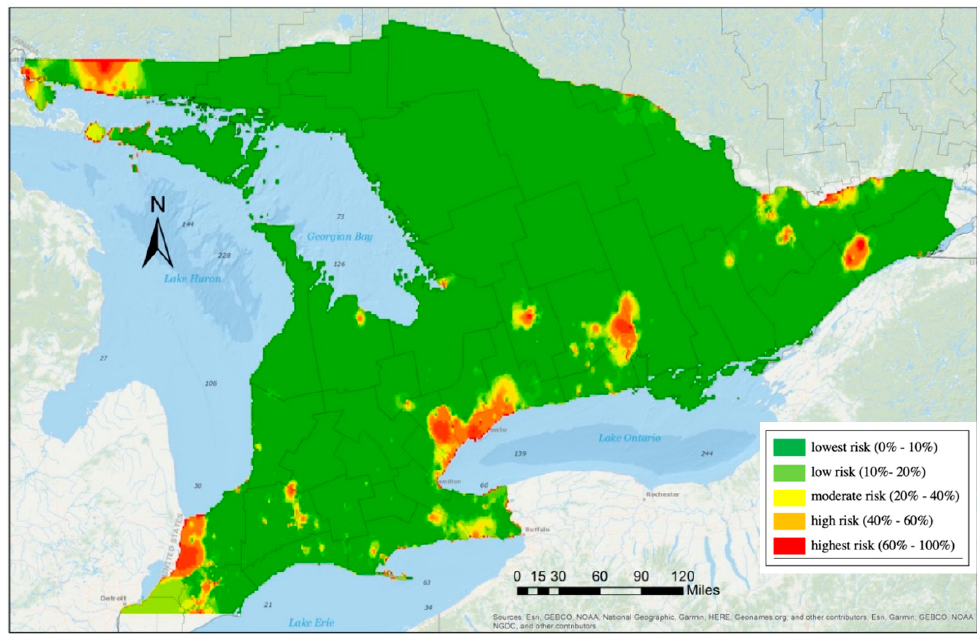
Figure 6. Projection of the risk map in southern Ontario. Predicted probabilities are based on the GLMM with regional random effect (Model 2 in Table 6).